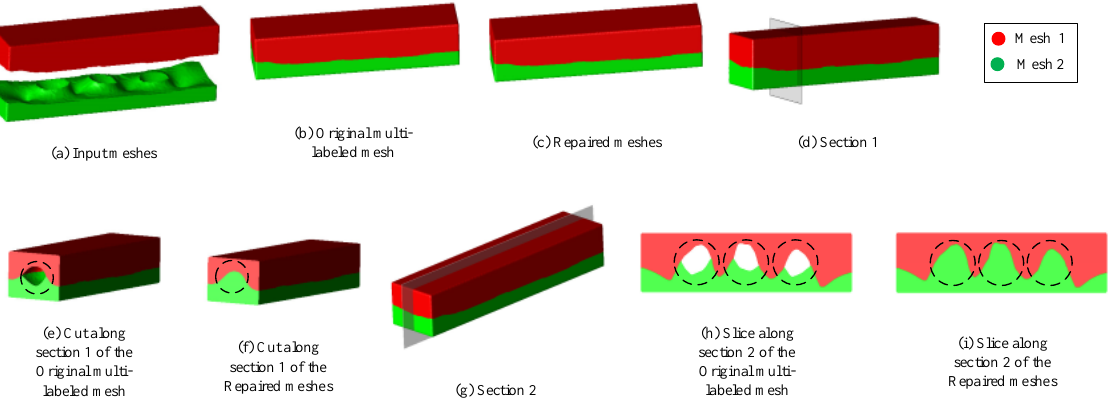
Figure 6. The multi-labeled mesh with input two sub-meshes. Table 1. Parameters of the multi-labeled mesh with input two sub-meshes. N V is the number of voids, the Time is the time consumed in repairing the mesh, the Facets is the number of the triangular facets in multi-labeled mesh, the Vertexes is the number of mesh vertexes in multi-labeled mesh.